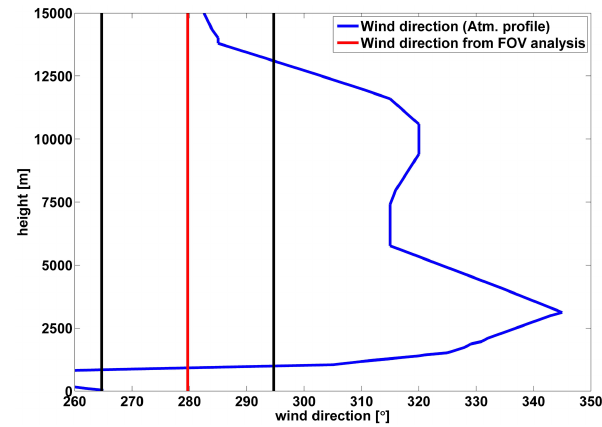
Fig. 8. Wind direction profile as measured by a radiosonde. The calculated wind direction in the cloud layer according to the FOV analysis is 280 ◦ ± 15 ◦